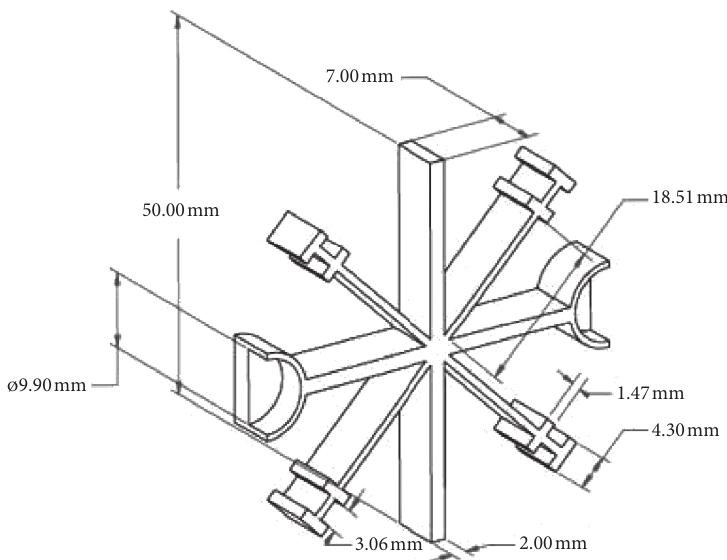
Figure 2: Metamaterial cantilever beams and central magnet used in model simulations. Table 1: Properties and dimensions of the metamaterial vibration attenuation energy harvesting structure used in model